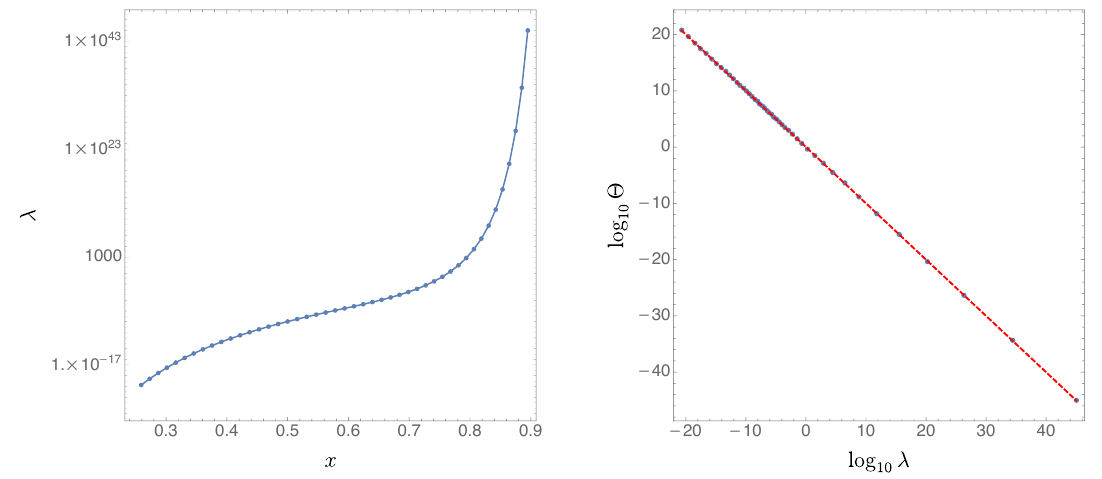
Figure 6 . Left: Logarithmic plot of the a(cid:14)ne parameter (cid:21) as a function of x on H + . Right: log (cid:0) log plot of the expansion (cid:2) as a function of (cid:21) . The dashed red line indicates a best 10 10 (cid:12)t consistent with log (cid:2) = 0 : 00195019 (cid:0) log (cid:21) . Both panels were generated with T 1 =T BH (cid:25) 10 10 0 : 729262.